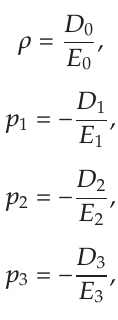
For this solution the parametric EoS looks